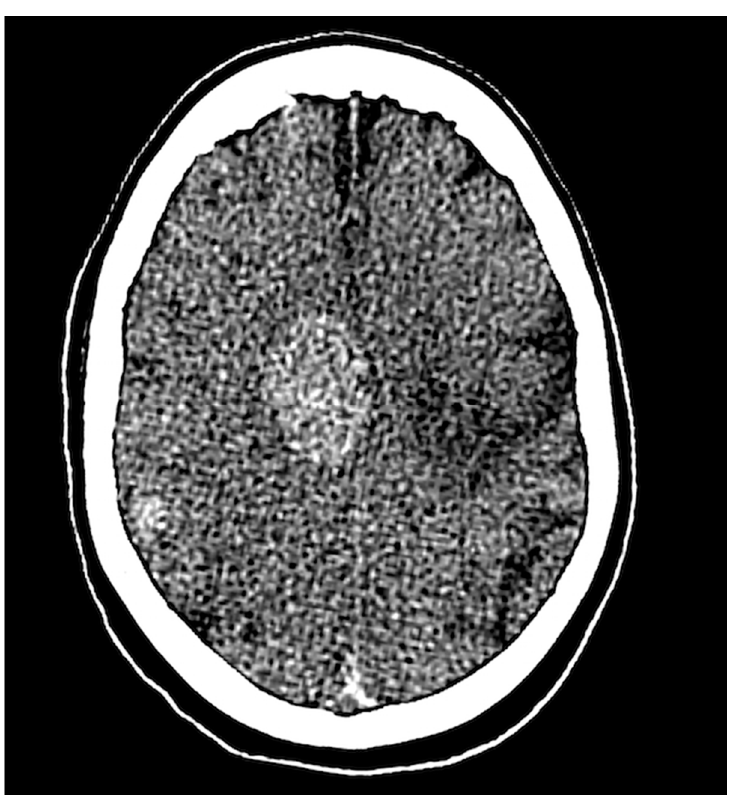
Figure 3. This figure shows multiple dense intra-cranial masses in the right hemisphere identified by PMCT in a 67-year-old male recently diagnosed with a stage IV small-cell lung carcinoma. The patient experienced no neurological complaints and showed no abnormalities during the neurological examination. The intra-cranial masses were suspected to be cerebral metastases